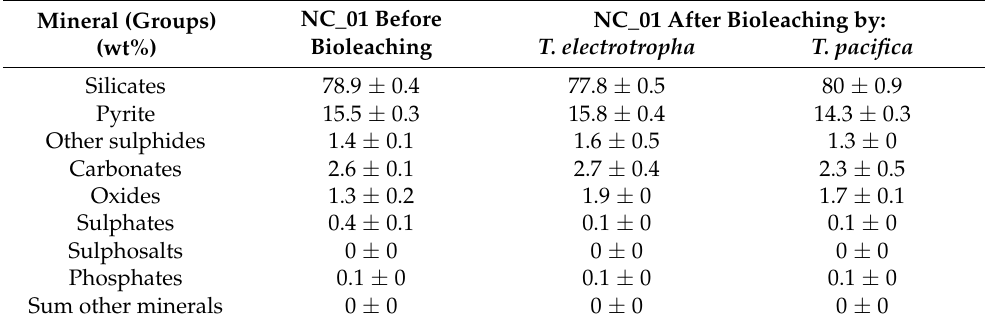
Table A11. Mineral compositions of the Neves Corvo waste rock (NC_01) before and after bioleaching obtained from the SEM/MLA-GXMAP.